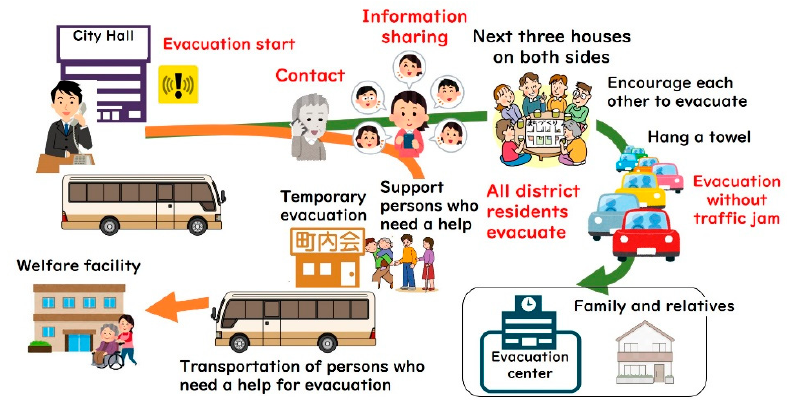
Figure 4. A screenshot of evacuation simulation by car used for explanatory material.